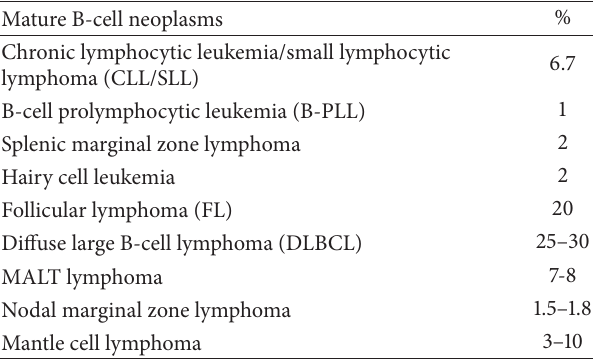
Table 1: Mature B-cell neoplasms classification. Mature B-cell